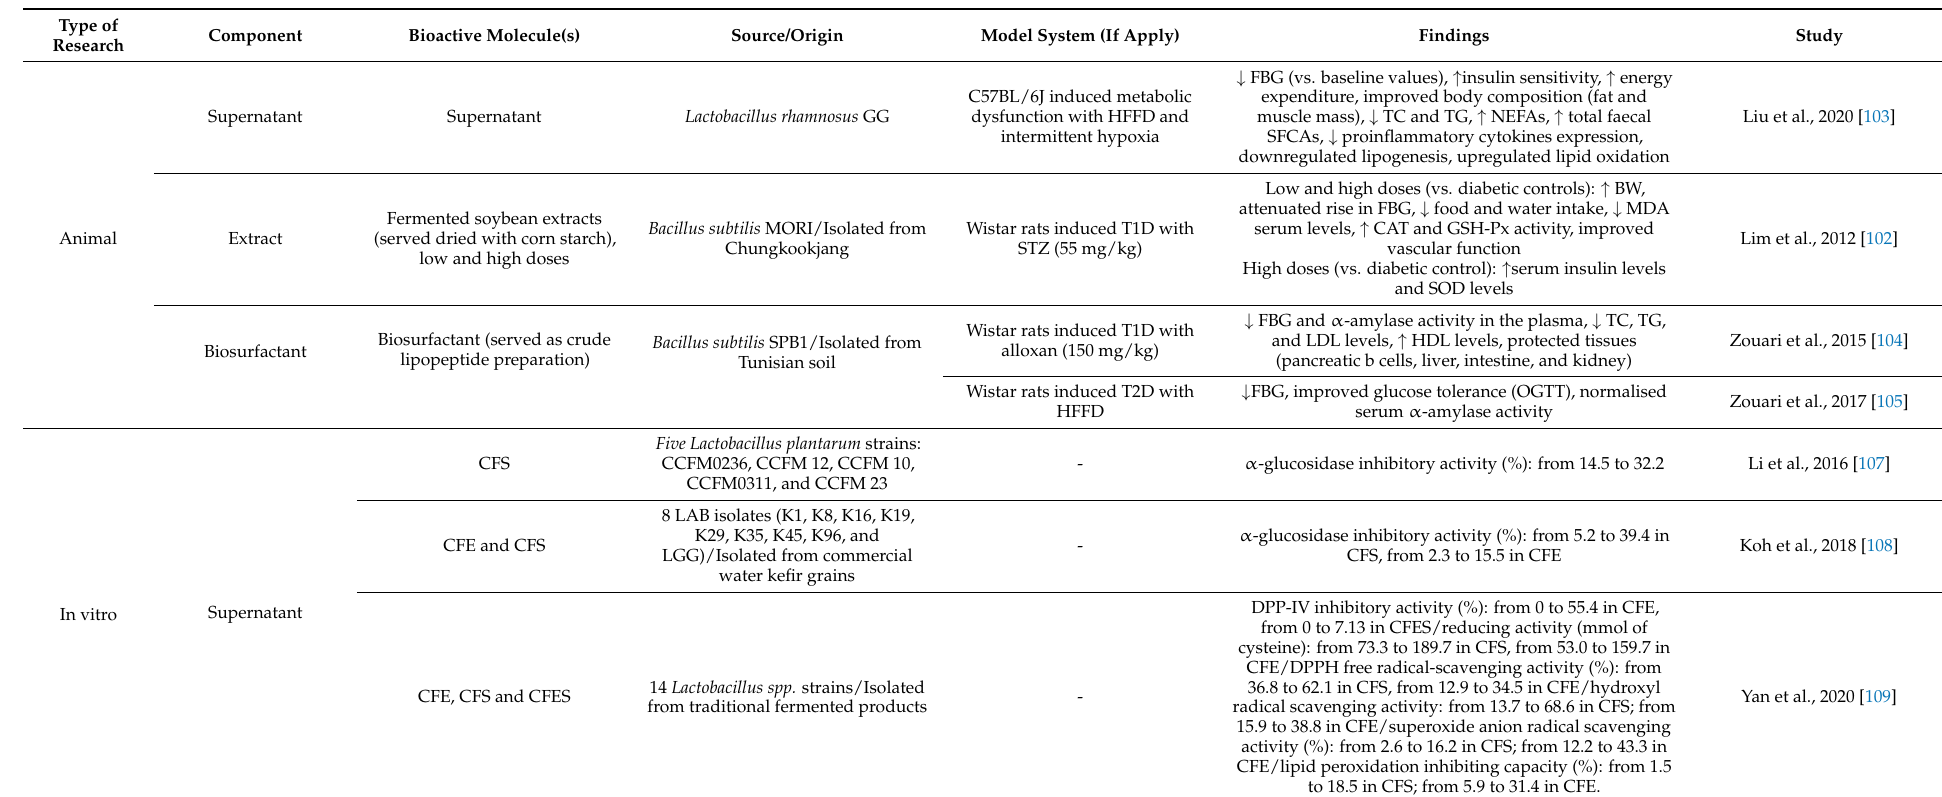
Table 3. Experimental evidence on the effects of microbial supernatants, extracts, and biosurfactants in diabetes